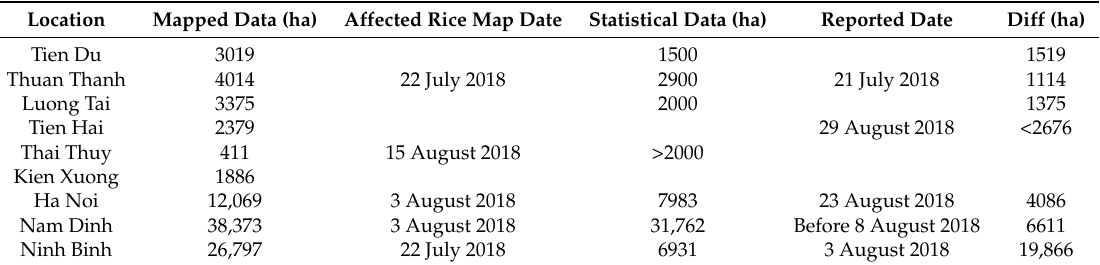
Table 10. Comparison of affected rice area reported by GSO statistics our proposed